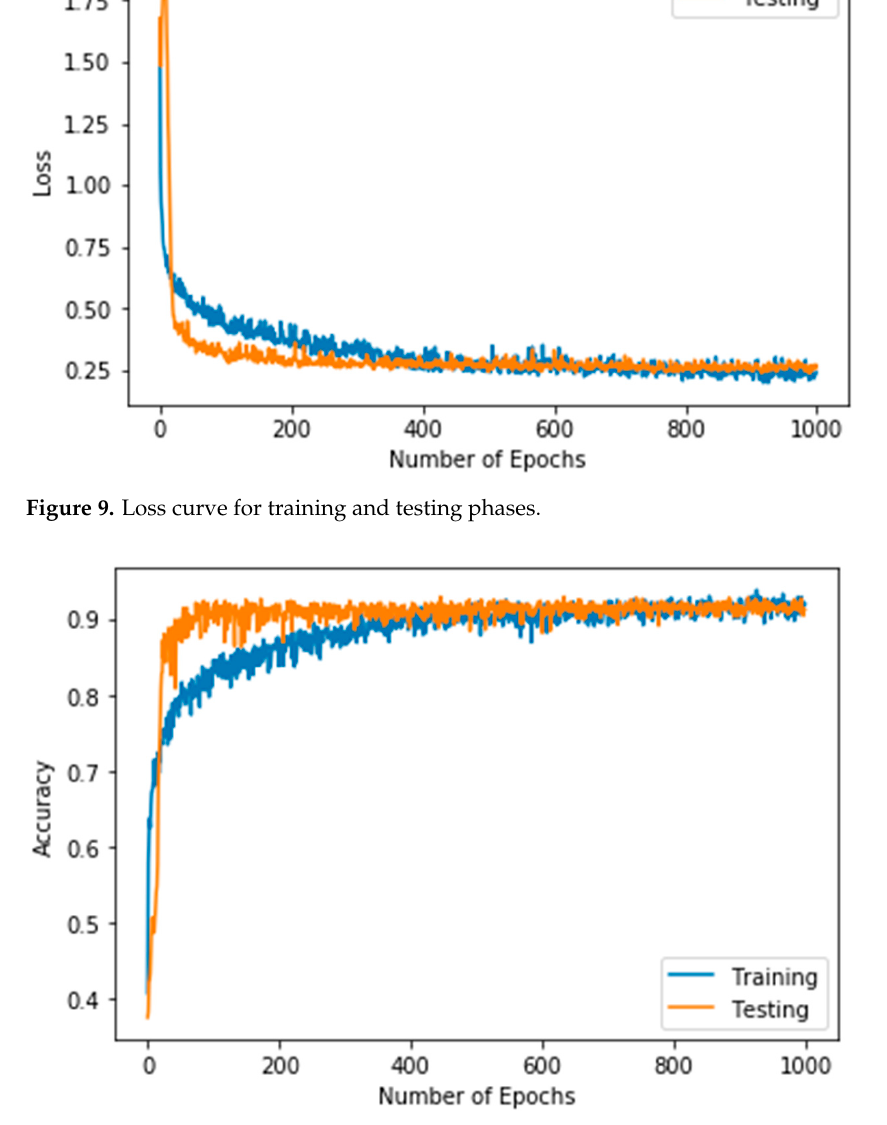
Figure 10. Accuracy for training and testing phases.